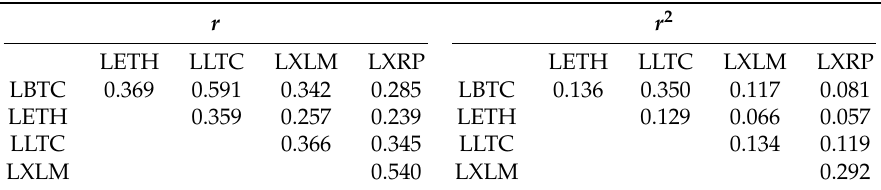
Table 2. Correlation coefficients, r and the coefficients of determination, r 2 . This table presents the Pearson’s correlation coefficients and the coefficients of determination of log-returns of the five